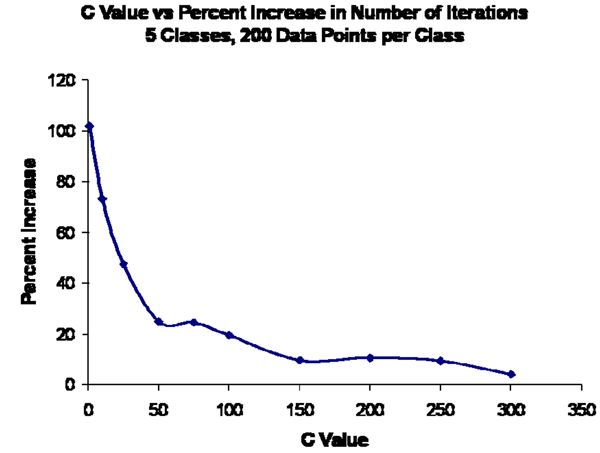
The percent increase in iterations-to-convergence against the 'C' value. For very low values of 'C' the gain is doubled while for very large values of 'C' the gain is low (almost constant for C > 150). Thus we note the dependence of the gain on 'C' value.